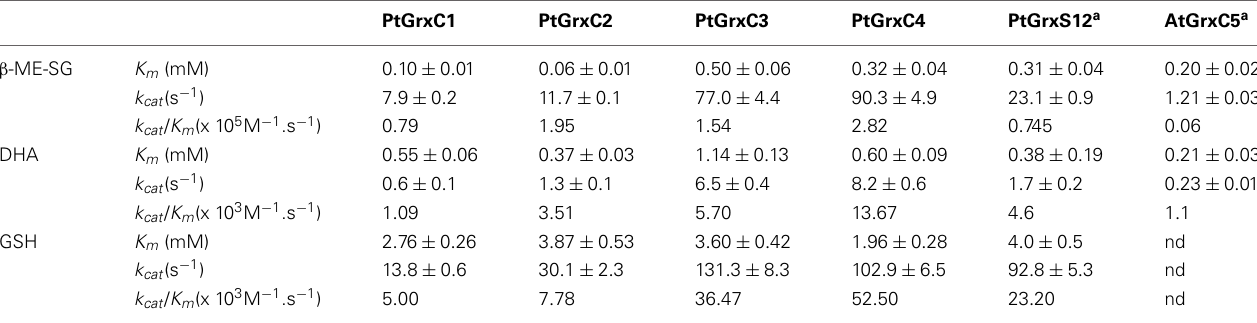
Table 1 | Kinetic parameters of poplar dithiol class I